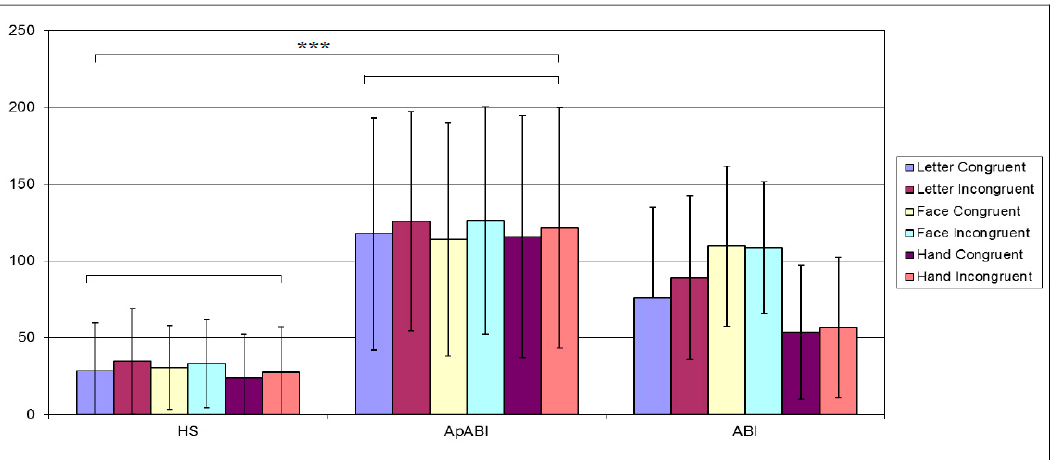
Figure 6. Number of missing trials in healthy subjects, ApABI and ABI patients for the L-FT, F-FT, H-FT, and both congruent and incongruent trials. *** stand for p ≤